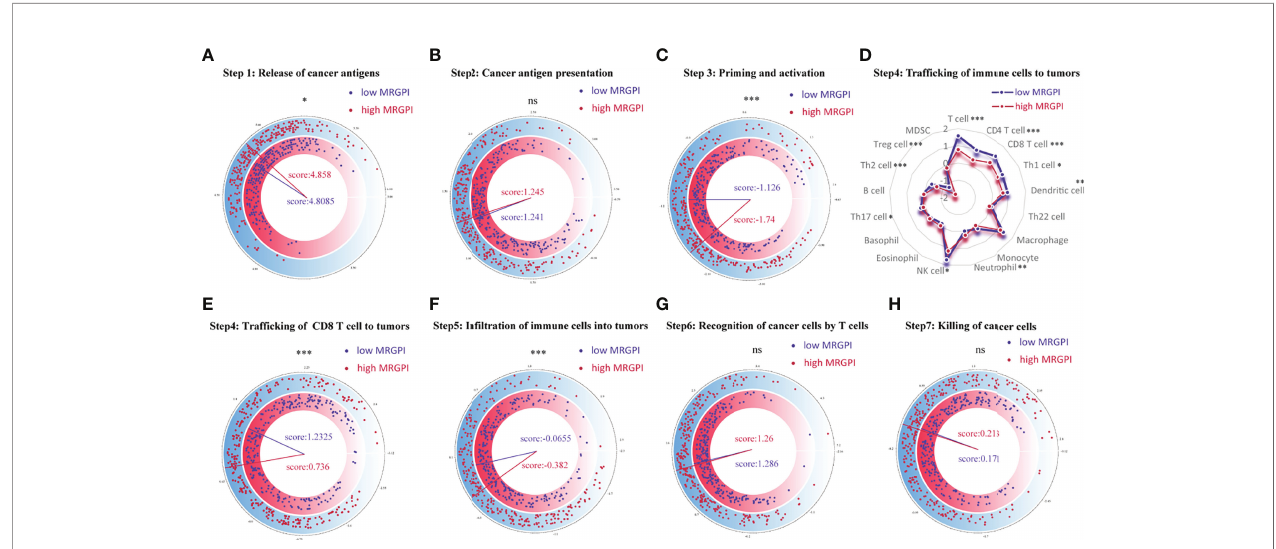
FIGURE 3 | Correlation between scores of the seven-step cancer-immunity cycle and the MRGPI subgroups. (A) The quantity of release of cancer antigens (step 1 of the seven-step cancer-immunity cycle) between the MRGPI subgroups. (B) The quantity of cancer antigen presentation (step 2) between the MRGPI subgroups. (C) The ability of priming and activating immune cells (step 3) between the MRGPI subgroups. (D) The ability of traf fi cking kinds of immune cells to tumors (step 4) between the MRGPI subgroups. (E) The ability of traf fi cking CD8 T cells to tumors (step 4) between the MRGPI subgroups. (F) The degree of in fi ltration of immune cells into tumors (step 5). (G) The ability of recognizing cancer cells by T cells (step 6). (H) The ability of killing cancer cells (step 7) between the MRGPI subgroups. MRGPI, metabolism-related gene prognostic